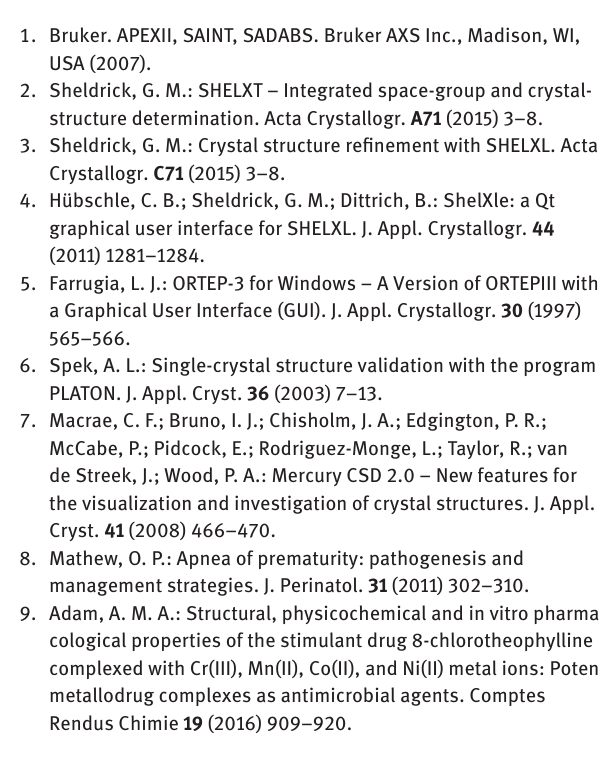
expected ranges. The molecule is essentially planar with a RMS deviation of 0.02 Å for all non-hydrogen atoms except the terminal ethyl group carbon atom. The least square plane defined by the ethyl group and its bonded nitrogen atom makes a dihedral angle of 88.8(1)° with the main molecular plane. The shortest intermolecular interaction is the